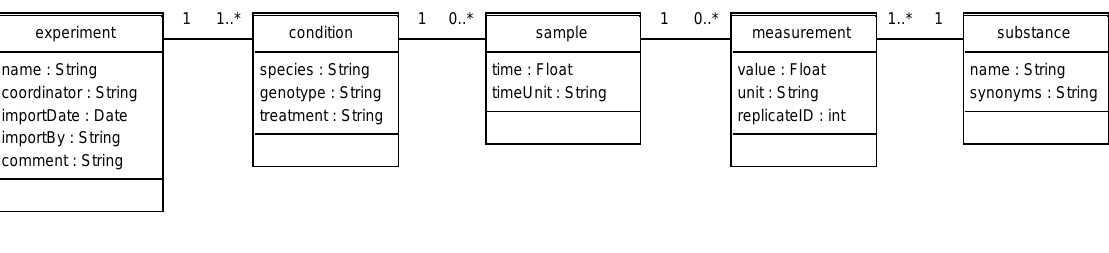
Figure 1: Data model for experiment data